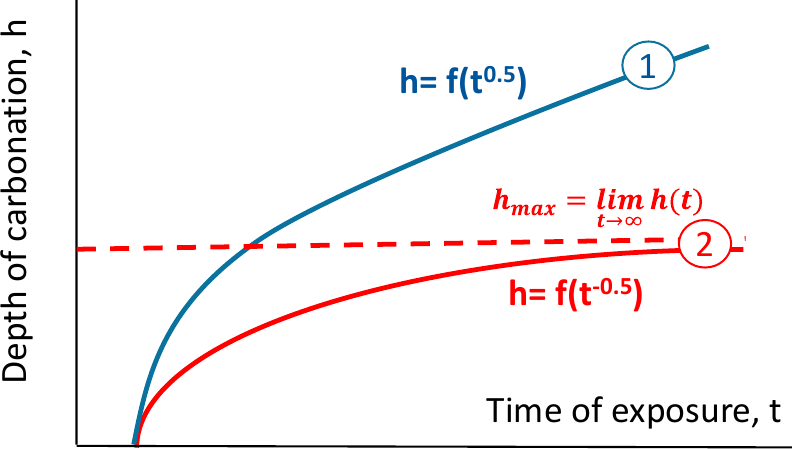
Figure 1. Traditional” power (1) and hyperbolic (2) models of carbonation phenomena.